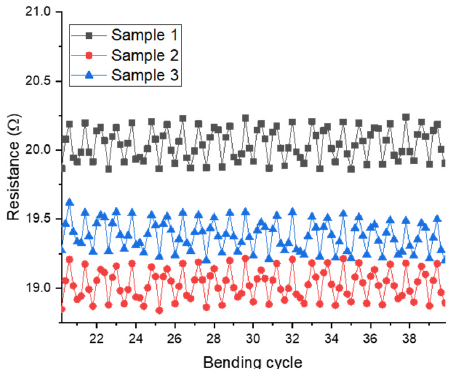
Figure 12. Bending test for resistance of silver trace printed on dry PVA film, in which each cycle goes from 0° → 50° → 90° → 50° → 0°. Bending within this range does not appear to lead to any significant loss of conductivity, even after multiple cycles.